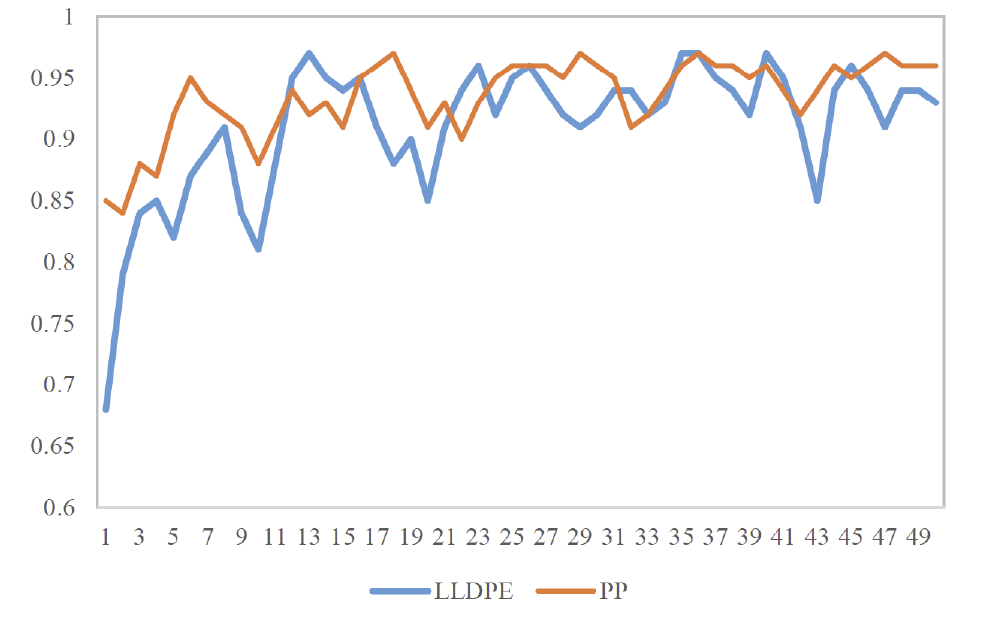
Figure 3. Change trend of fitness under different